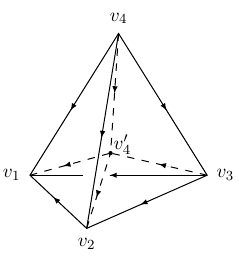
Figure 3. The topology of the action of A g